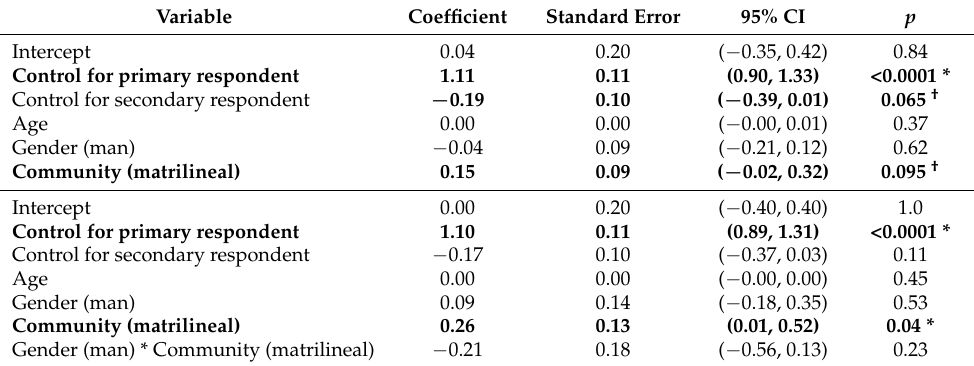
Table 3. Poisson generalized linear models of network degree by primary household survey respon- dent status, secondary household survey respondent status, age, gender, and community for all nodes of matrilineal and patrilineal Mosuo adults (n = 225).